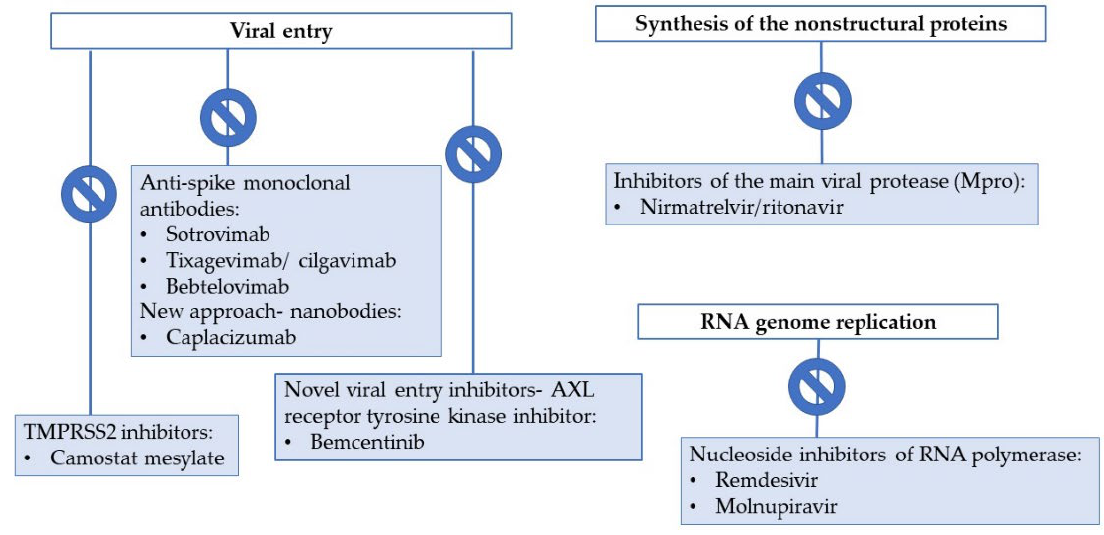
Figure 1. Diagram of direct acting antivirals in SARS-CoV-2 infection. 3.1.1. Entry Inhibitors: Anti-Spike Monoclonal Antibodies Anti-SARS-CoV-2 monoclonal antibodies (Mab) recognize specific epitopes on the viral spike protein, blocking receptor binding and membrane fusion. Neutralizing Mab can be isolated from convalescent patients’ memory B cells, using single-cell clonal amplification or by high-throughput single-cell RNA and VDJ sequencing of antigen-binding B cells [24]. Combinations of anti-SARS-CoV-2 Mab, binding to different regions of the spike glyco- protein, can efficiently inhibit viral replication, if administered during the first 7 days after infection, leading to a lower incidence of COVID-19-related hospitalizations and